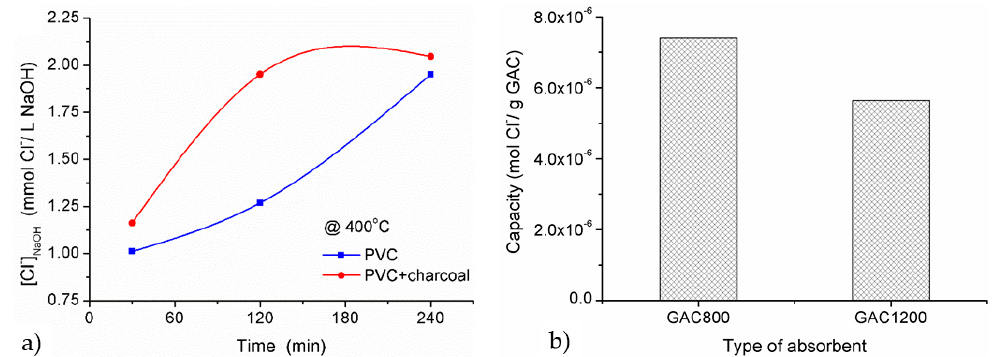
Figure 2. Quantitative analysis: ( a ) the amount of chloride ion captured in NaOH solution (blue) and without (red) charcoal heating media at 400 °C, ( b ) capacity of chlorinated gas